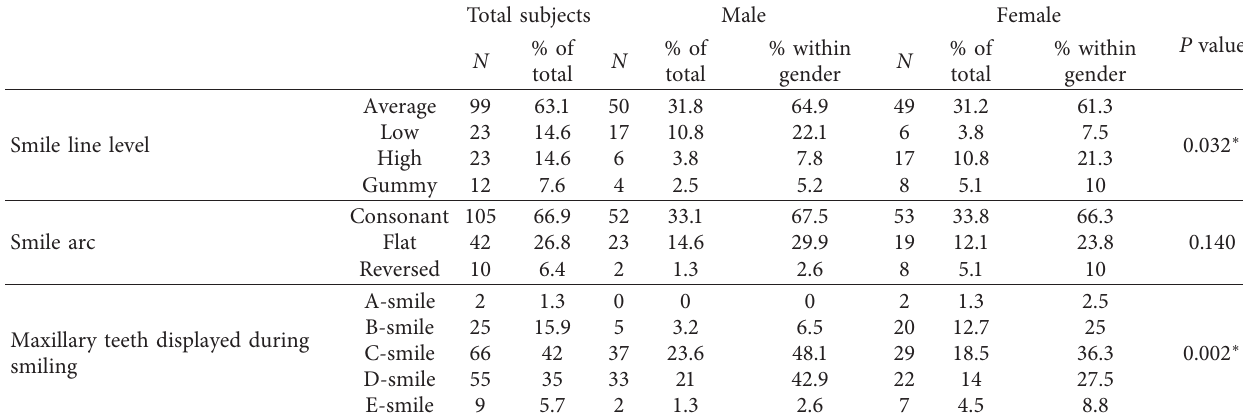
Table 5: Frequency of smile line, smile arc, maxillary teeth displayed during smiling of total subjects (males and females), and gender-based differences for various parameters using Pearson chi-square